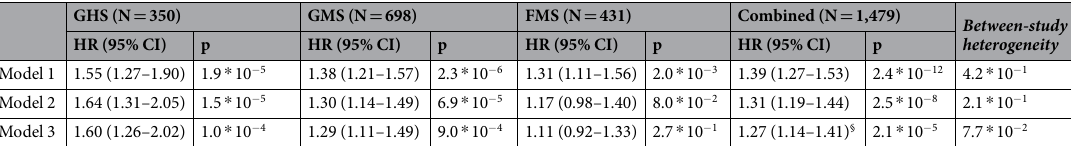
Table 2. Association between serum resistin and all-cause mortality in individual studies and in the combined sample. GHS: Gargano Heart Study; GMS: Gargano Mortality Study; FMS: Foggia Mortality Study. HRs (95% CI) are given for the increase of 1 SD of log transformed values of serum resistin. Model 1: unadjusted in individual studies and adjusted for study sample (i.e. GHS, GMS and FMS) in the combined analysis. Model 2: adjusted for sex, age at recruitment, smoking habits, BMI and study sample in the combined analysis. Model 3: adjusted for sex, age at recruitment, smoking habits, BMI, HbA1c, anti-hypertension and anti-dyslipidemia therapies and study sample in the combined analysis. § Robust 95%CI confidence interval (due to the presence of between-study heterogeneity, i.e. for p <